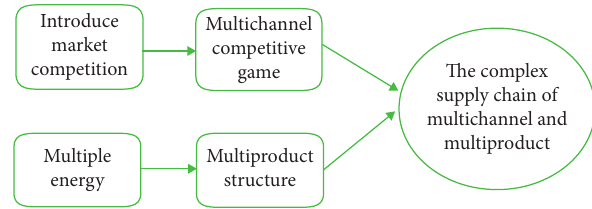
Figure 1: The structure of the supply